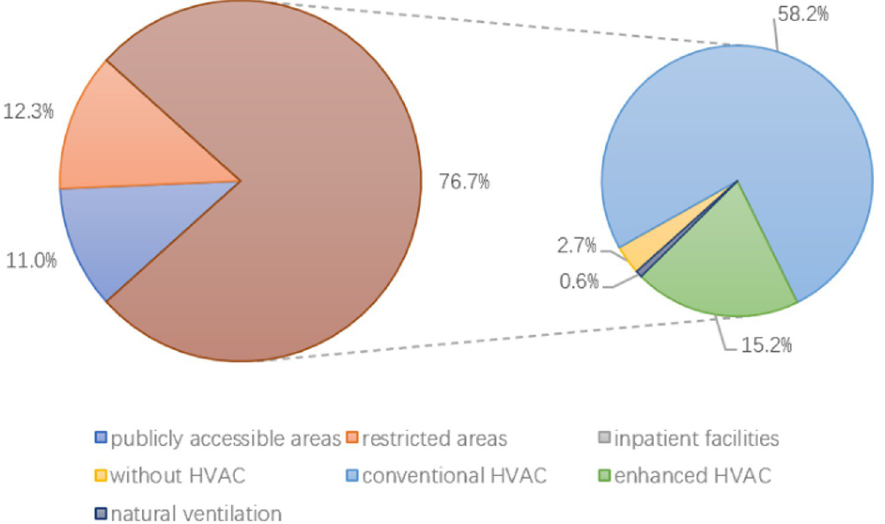
Fig 3. The distribution of fungal samples from different